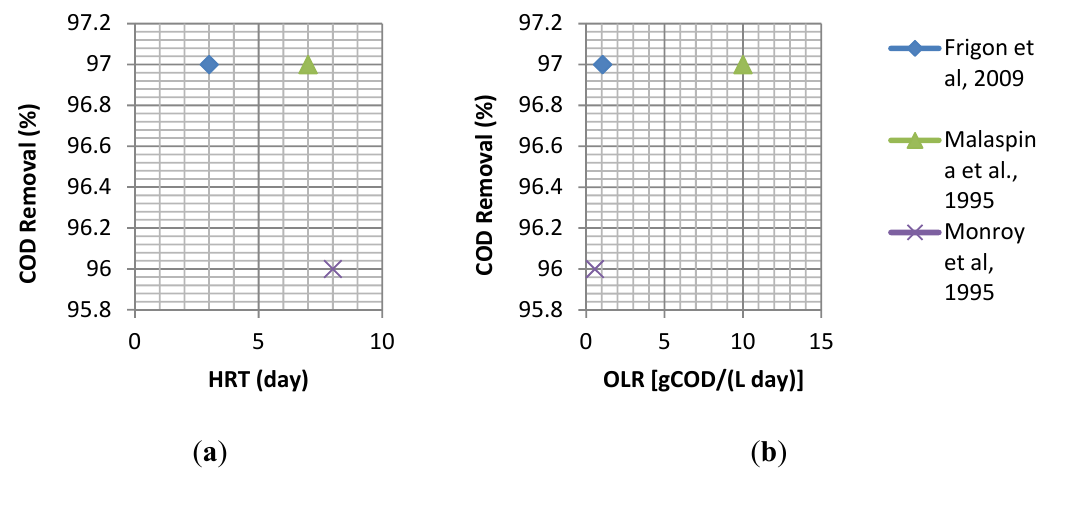
Figure 8. The highest COD removal versus ( a ) HRT (days) and ( b ) OLR [g COD/(L day)] using two steps anaerobic/aerobic digestion system for CW